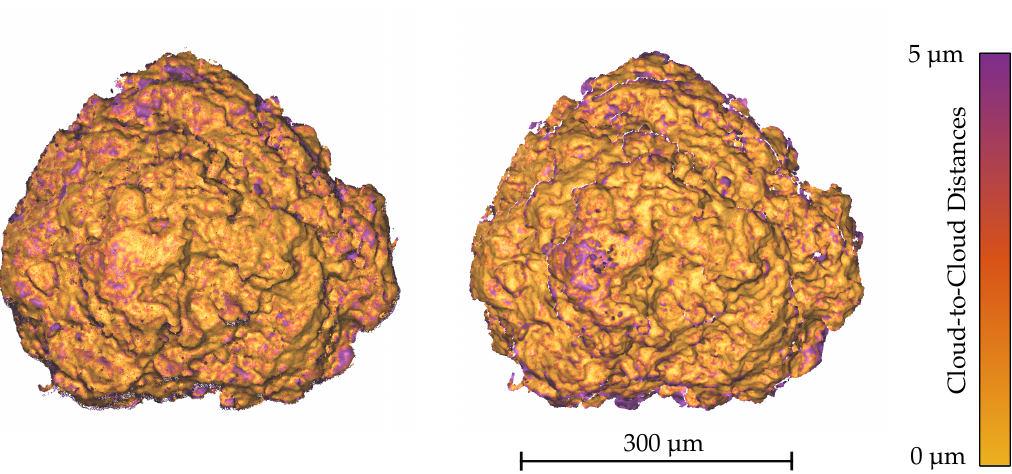
Figure 14. CLSM measurement (left, 1081582 points) and the dense point cloud triangulated with a triangulation angle of ∆ ϕ Y = 5 ◦ (right, 327997 points) using the orthographic factorization method for the image sequence Gravel